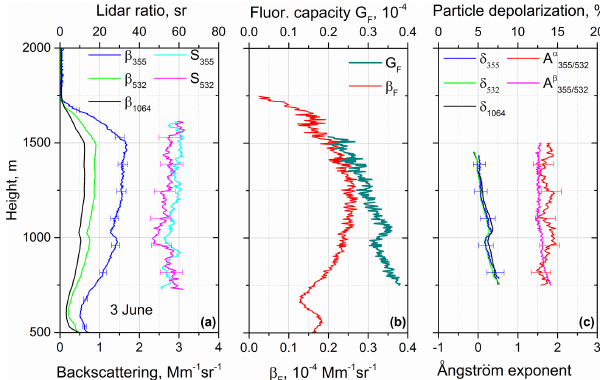
Figure 3. Measurements in the condition of background aerosol predominance. Vertical profiles of (a) backscattering coefficients β 355 , β 532 and β 1064 as well as lidar ratios S 355 and S 532 . (b) Fluorescence backscattering β F and fluorescence capacity G F = β F /β 532 . (c) Particle linear depolarization ratios δ 355 , δ 532 and δ 1064 together with extinction and backscattering Ångström expo- nents A α and A β on 3 June 2020 for 20:30–23:00UTC. 355 / 532 355 / 532 Measurements were performed at 30 ◦ to the horizon.